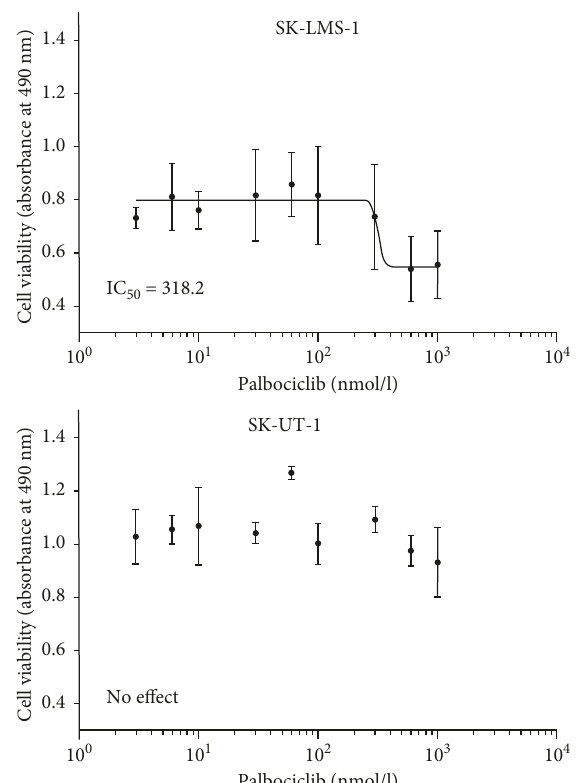
Figure 2: Growth inhibitory effect of palbociclib on SK-LMS-1 and SK-UT-1. Cells were cultivated on 96 plates and treated with in- creasing concentrations of palbociclib (3–1000nmol/l) for 72 hours. The MTS assay was used for determining cell